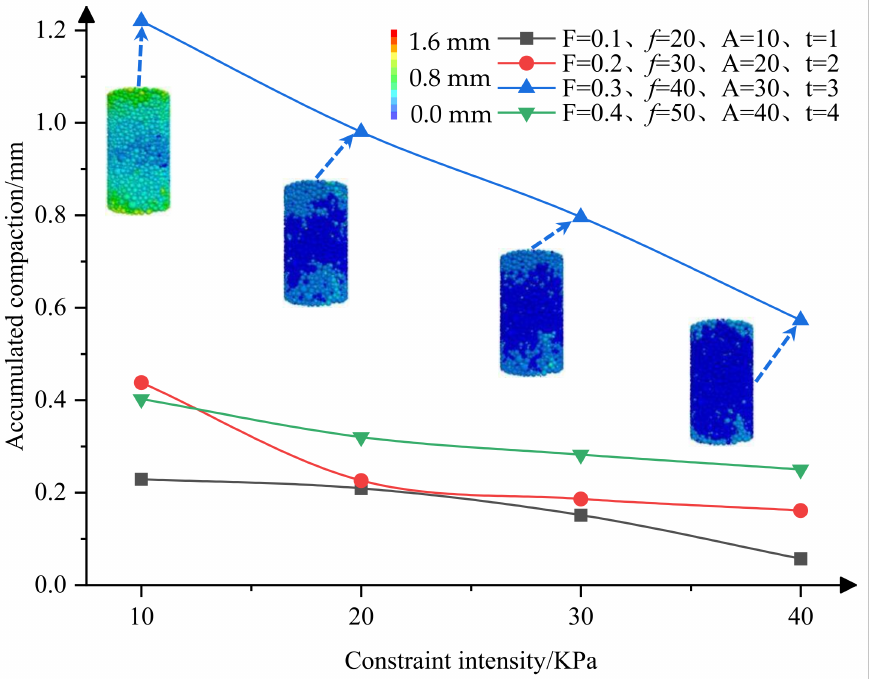
Figure 16. Change of cumulative compaction under constraint strength (x-axis shows the sand-gabion restraint strength and y-axis shows the compaction